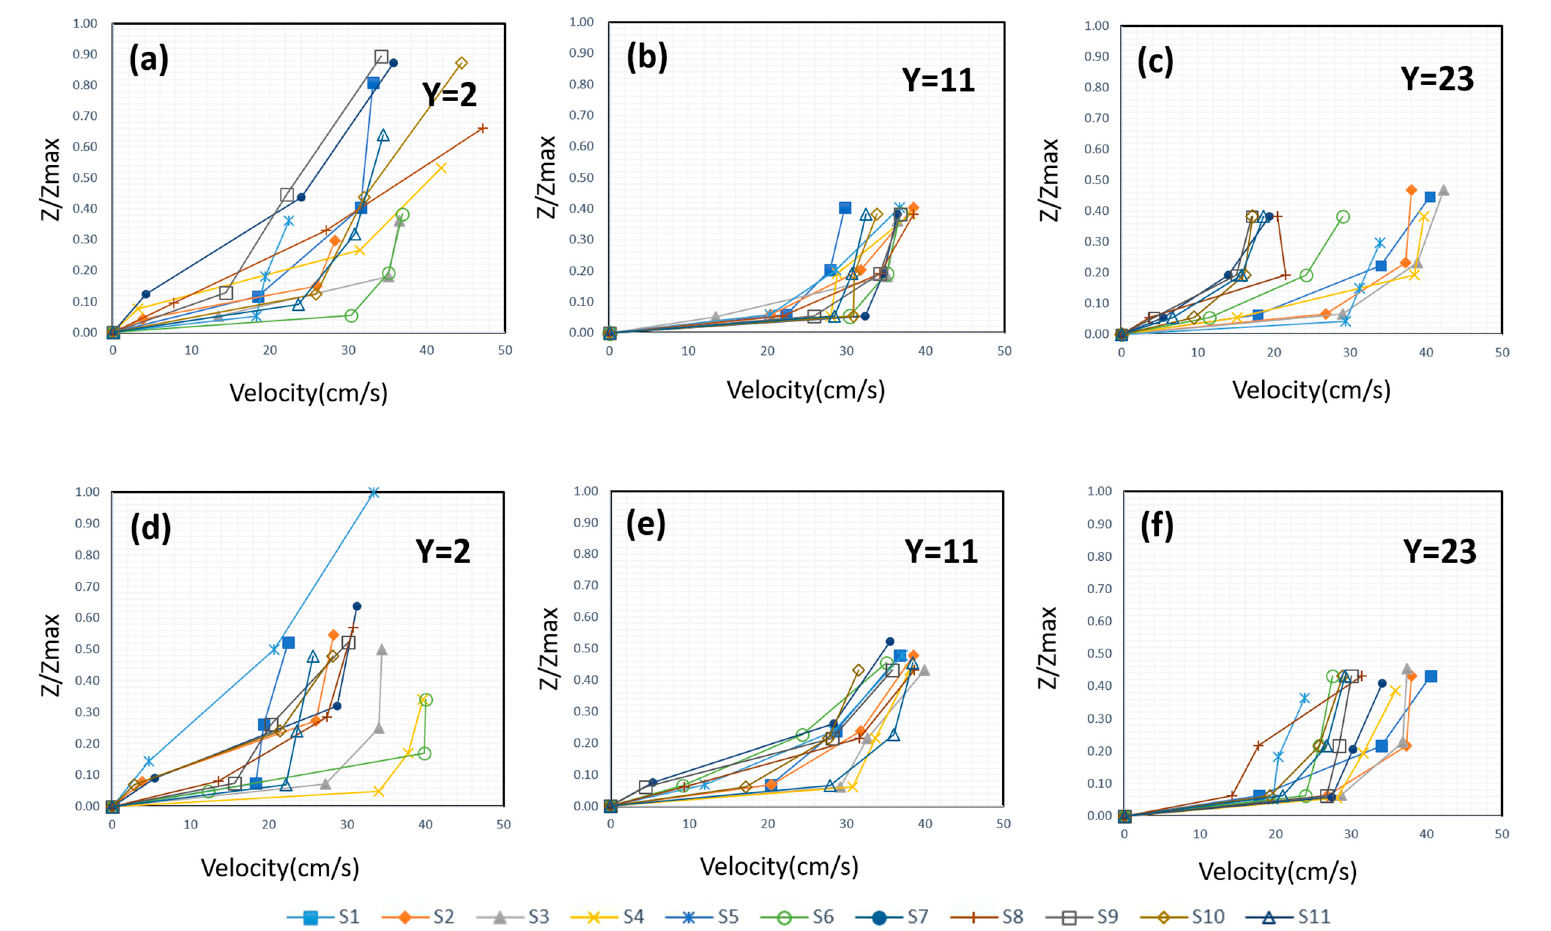
Figure 7. The sectional vertical velocity and its dimensionless scouring with ( a )–( c ) non-spur protection, and ( d )–( f ) spur protection in the flood return period of 10 years.